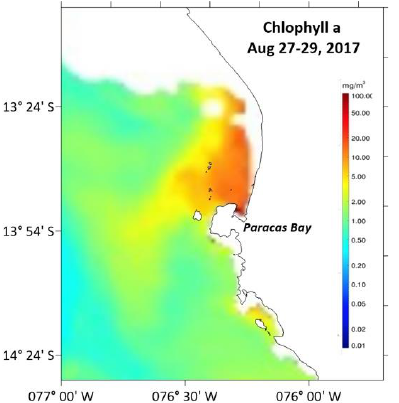
Figure 3. Surface distribution of chlorophyll- a VIIRS-NPP (27 – 29 August 2017). 3.1.2. Satellite Winds Coastal winds next to Paracas Bay came from the south and increased their intensity from 25 August (6 m s −1 ) to values above 10 m s −1 by 30 August, before falling to 5 m s −1 by 1 September (Figure 4a – c).